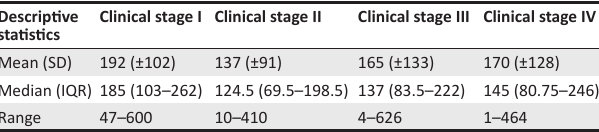
TABLE 4: CD4 count (cells/mm 3 ) at initiation of combination antiretroviral therapy stratified against clinical stage.